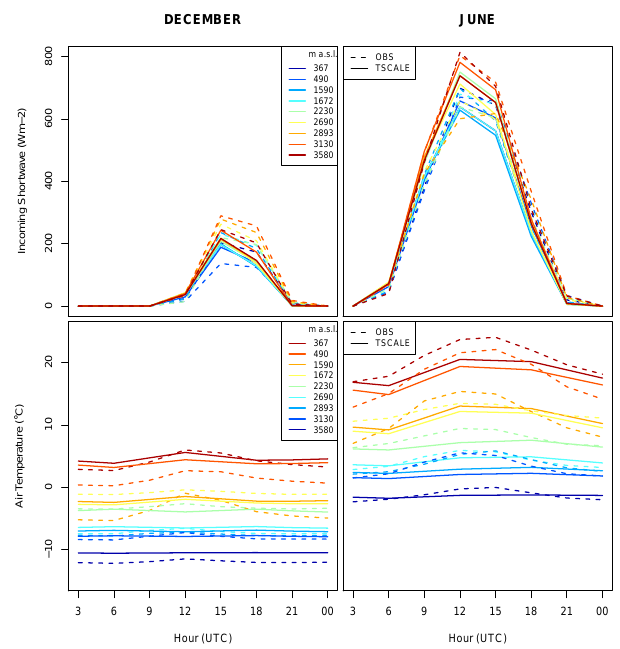
Fig. 10. The diurnal cycle of T and SW ↓ as averages of all 03:00– 00:00UTC 3h time steps over the entire study period, for months of December and June. TopoSCALE is compared to a subset of OBS stations representing an elevation range of 370 (LOC)–3580 (JFJ) ma.s.l. TopoSCALE given by solid line, OBS given by dashed